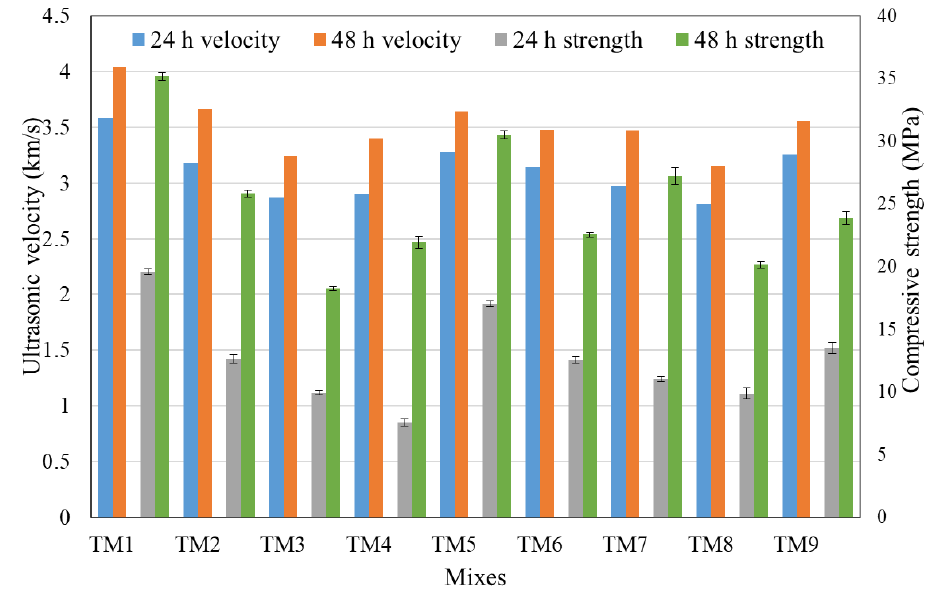
Figure 6. Compressive strength and ultrasonic velocities at 24 and 48 h.